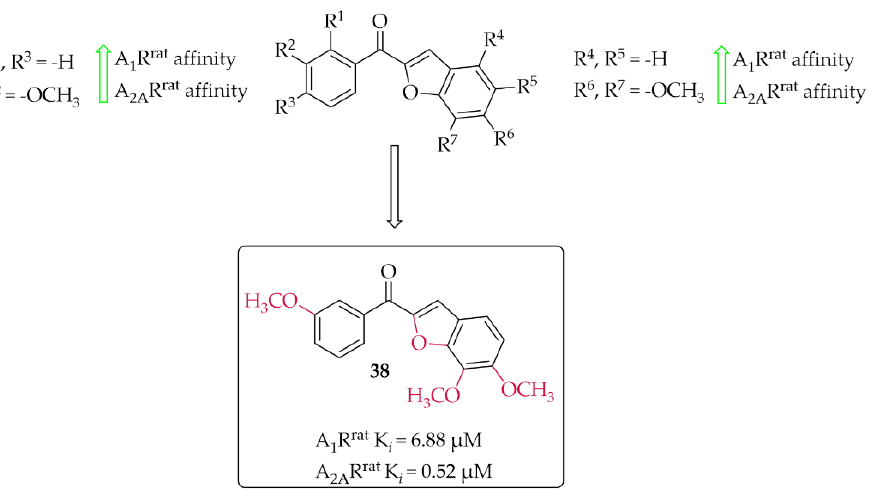
Figure 29. 2-Benzoyl-1-benzofurans as adenosine A 1 and A 2A receptor ligands and the most potent compound in this series [67].